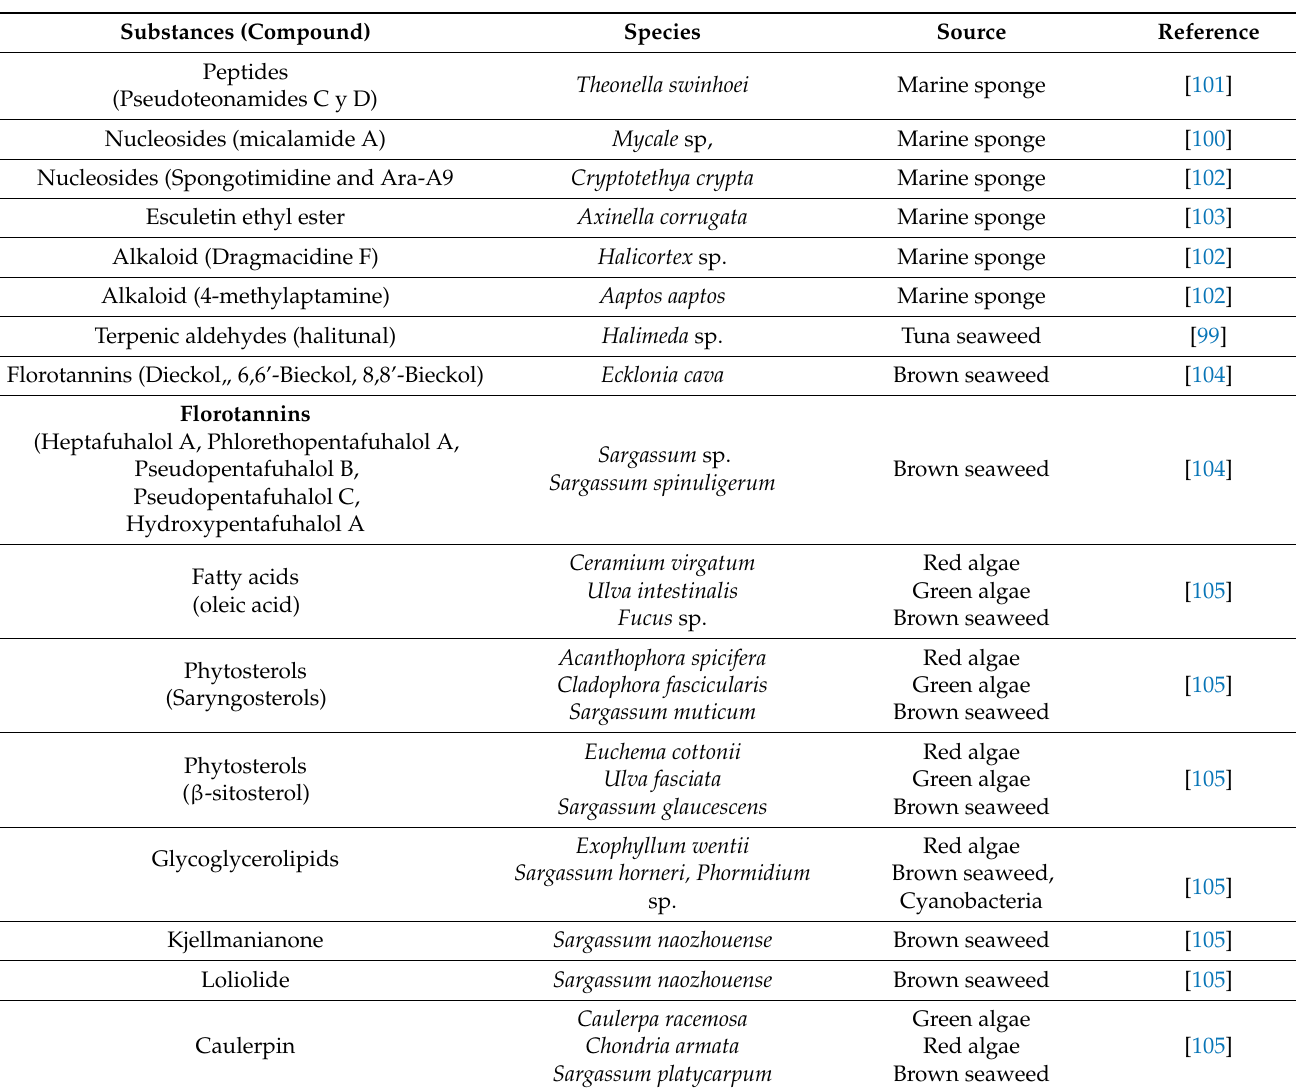
Table 4. Bioactive substances of marine origin have an antiviral activity to CoV and other